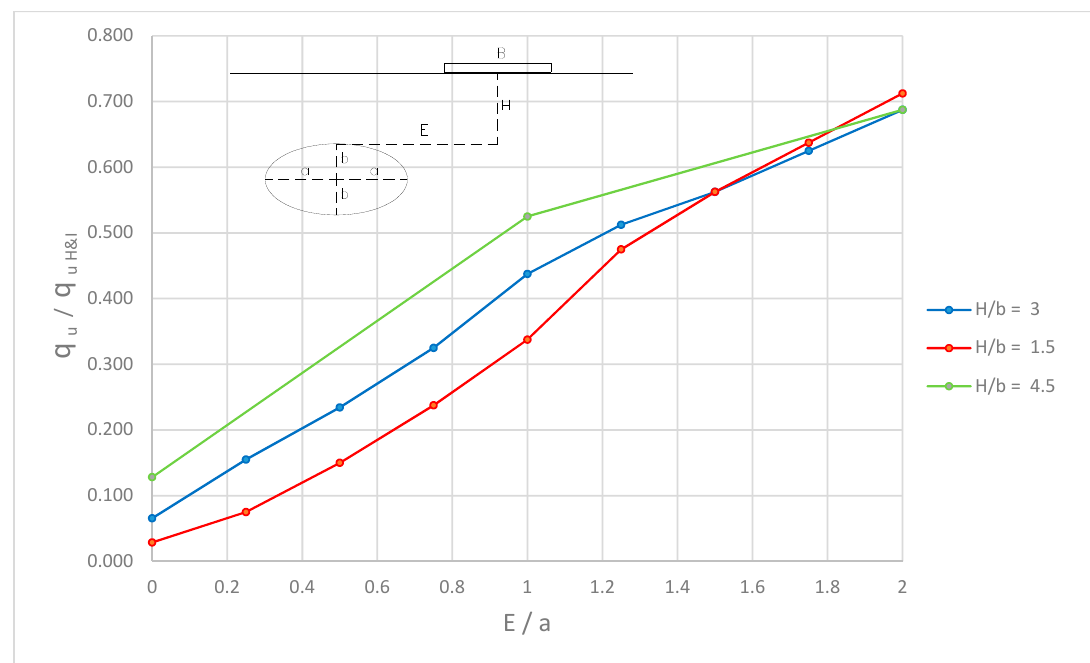
Figure 7. The load eccentricity on the ultimate bearing capacity for values between E/a = 0 and E/a = 12.